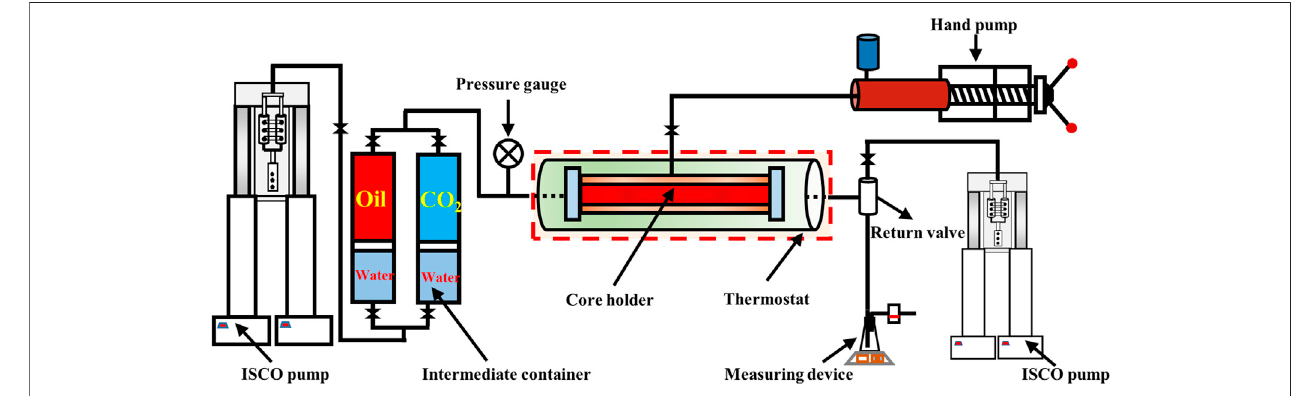
FIGURE 1 | Schematic diagram of CO 2 fl ooding experiment.